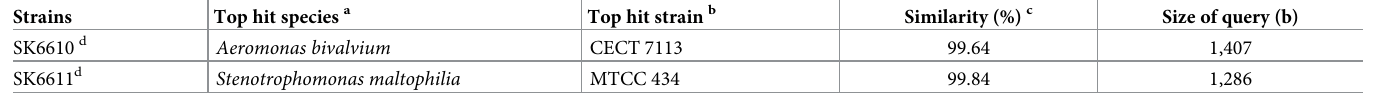
Table 4. Bacteria isolated from guts of amphipods housed with antibiotics. Strains Top hit species